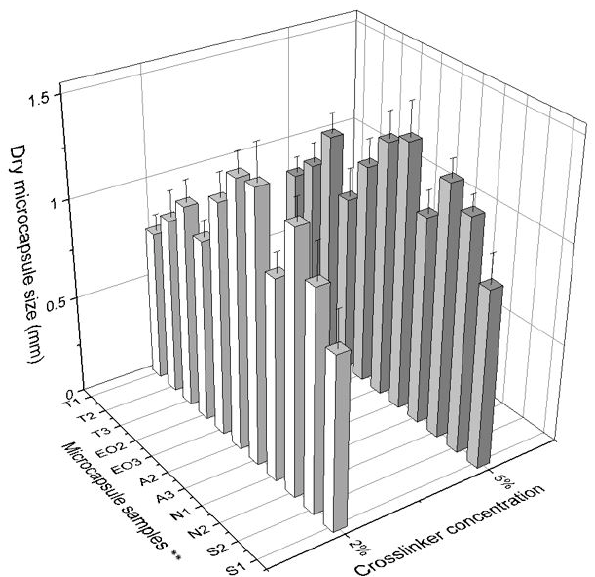
Figure 7. The effect of crosslinker concentration on the size of wet microcapsules. ** The code is given in Table 1, n = 30.